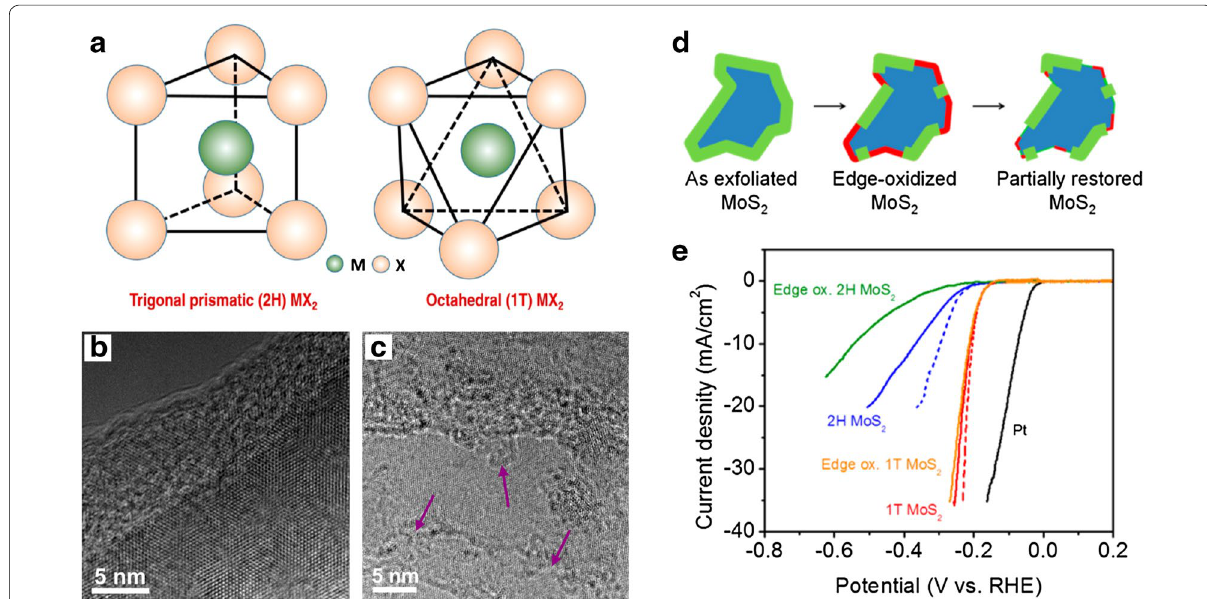
Fig. 3 a Unit cell structures of 2H-MoS 2 and 1T-MoS 2 . HRTEM images for b 2H-MoS 2 and c 1T-MoS 2 . d Schematic representation of the oxidation process and partial restoration of the MoS 2 edges after several voltammetric cycles. e HER polarization curves of 1T and 2H MoS 2 before and after edge oxidation. Dashed lines indicate the iR-corrected polarization curves (Figures reprinted with permission from Refs. [17, 35,